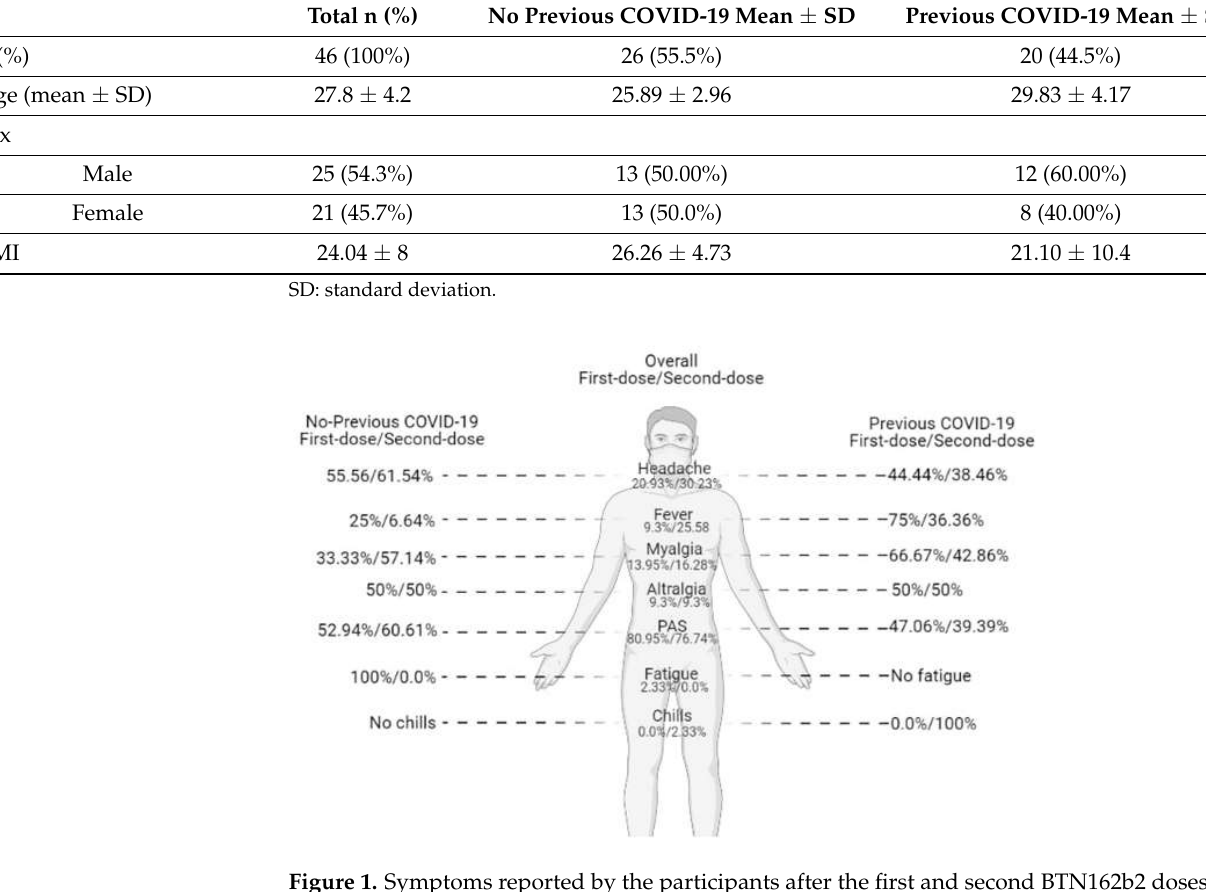
Table 1. Demographic, clinical, and antibody records.